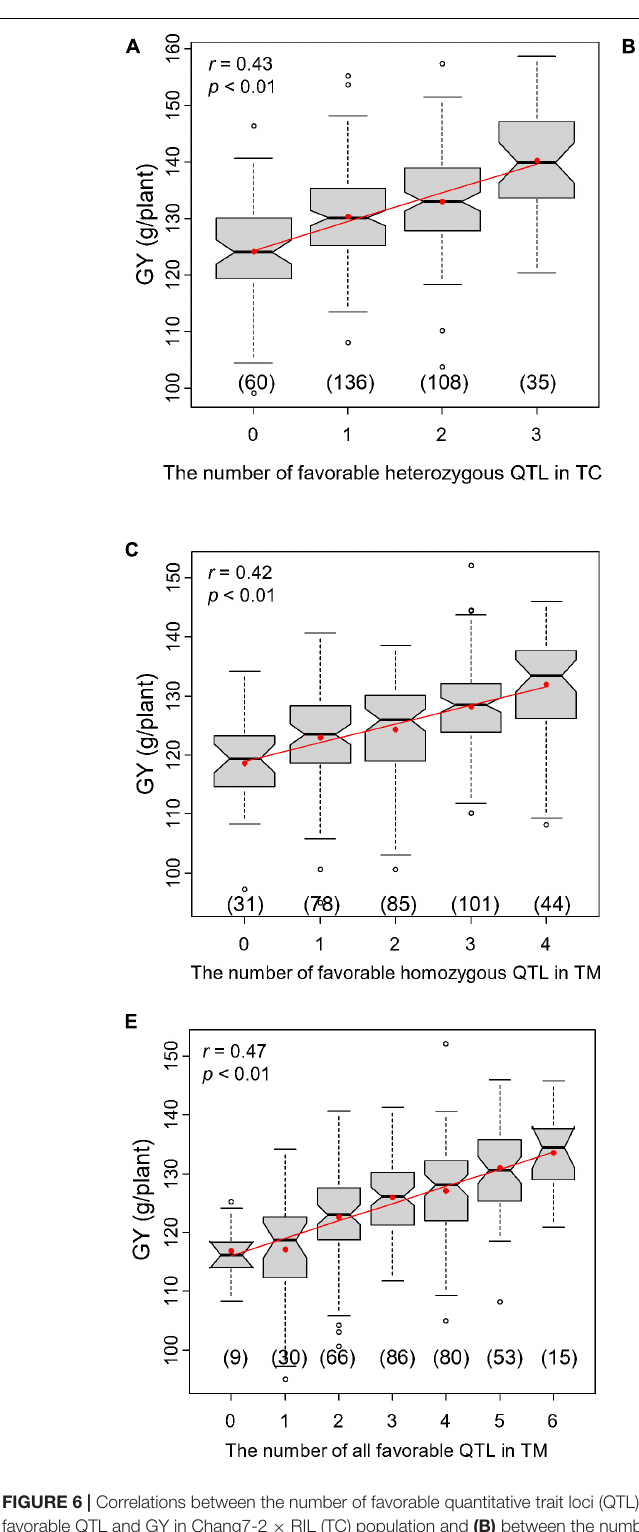
Frontiers in Plant Science |